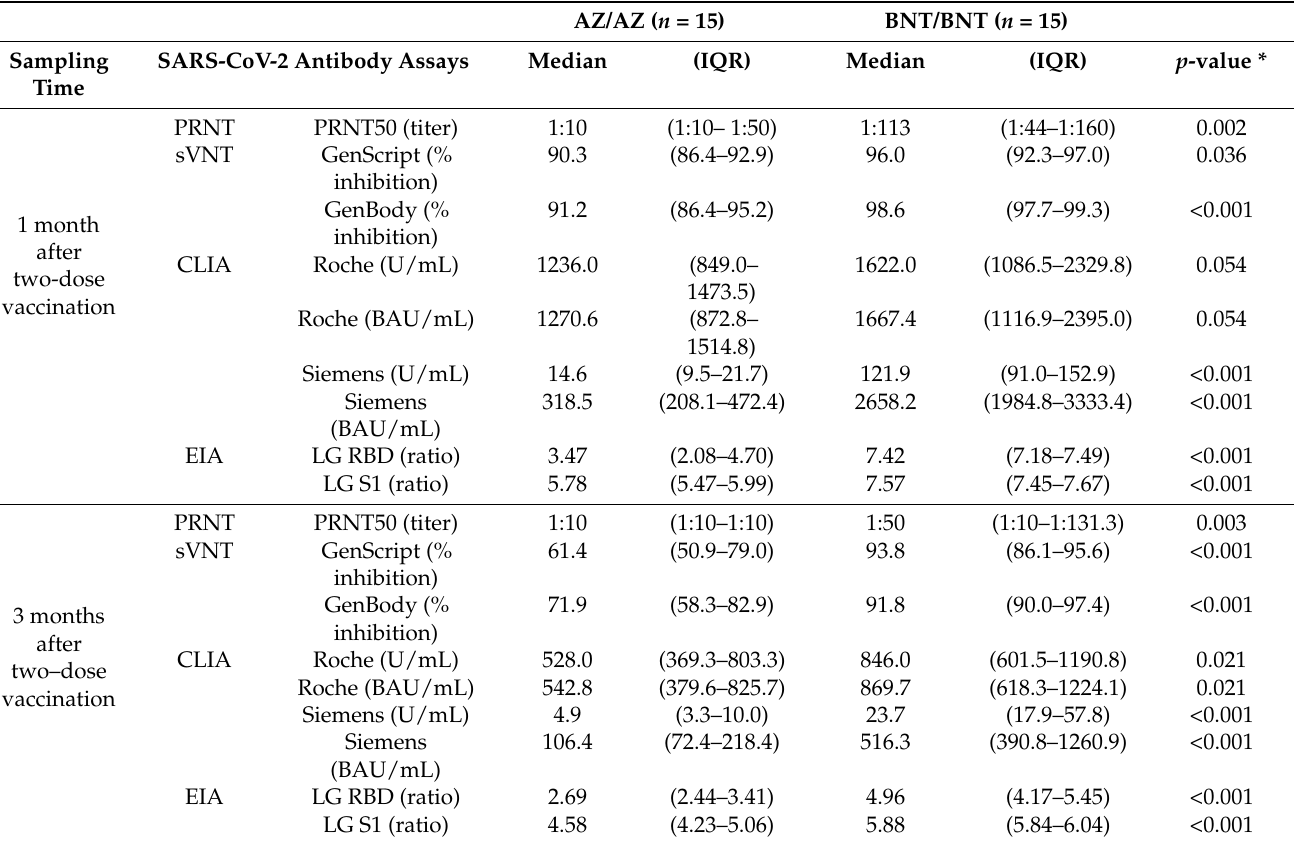
Table 1. Comparison of SARS-CoV-2 antibody results by PRNT, two sVNTs, two CLIAs, and two EIAs in AZ and BNT vaccinated participants at 1 and 3 months after the second dose of the vaccine. AZ/AZ ( n = 15) BNT/BNT ( n =